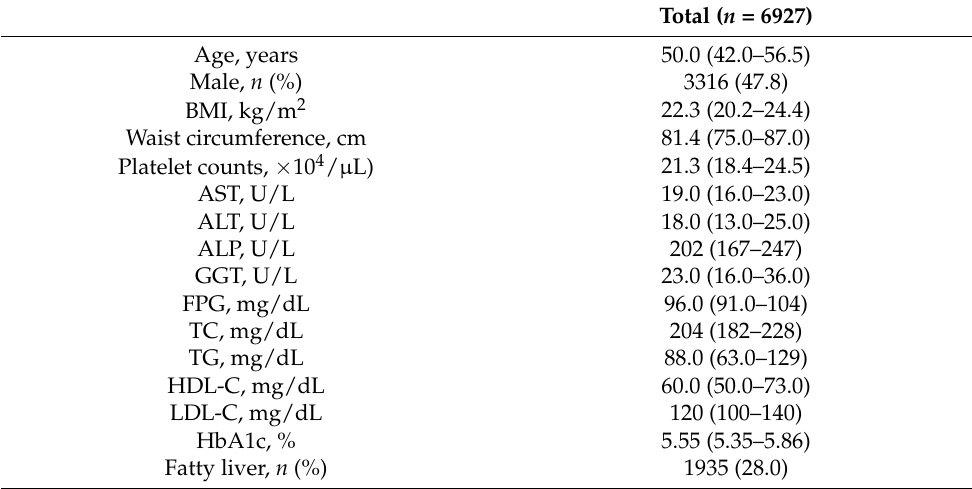
Table 1. Characteristics of